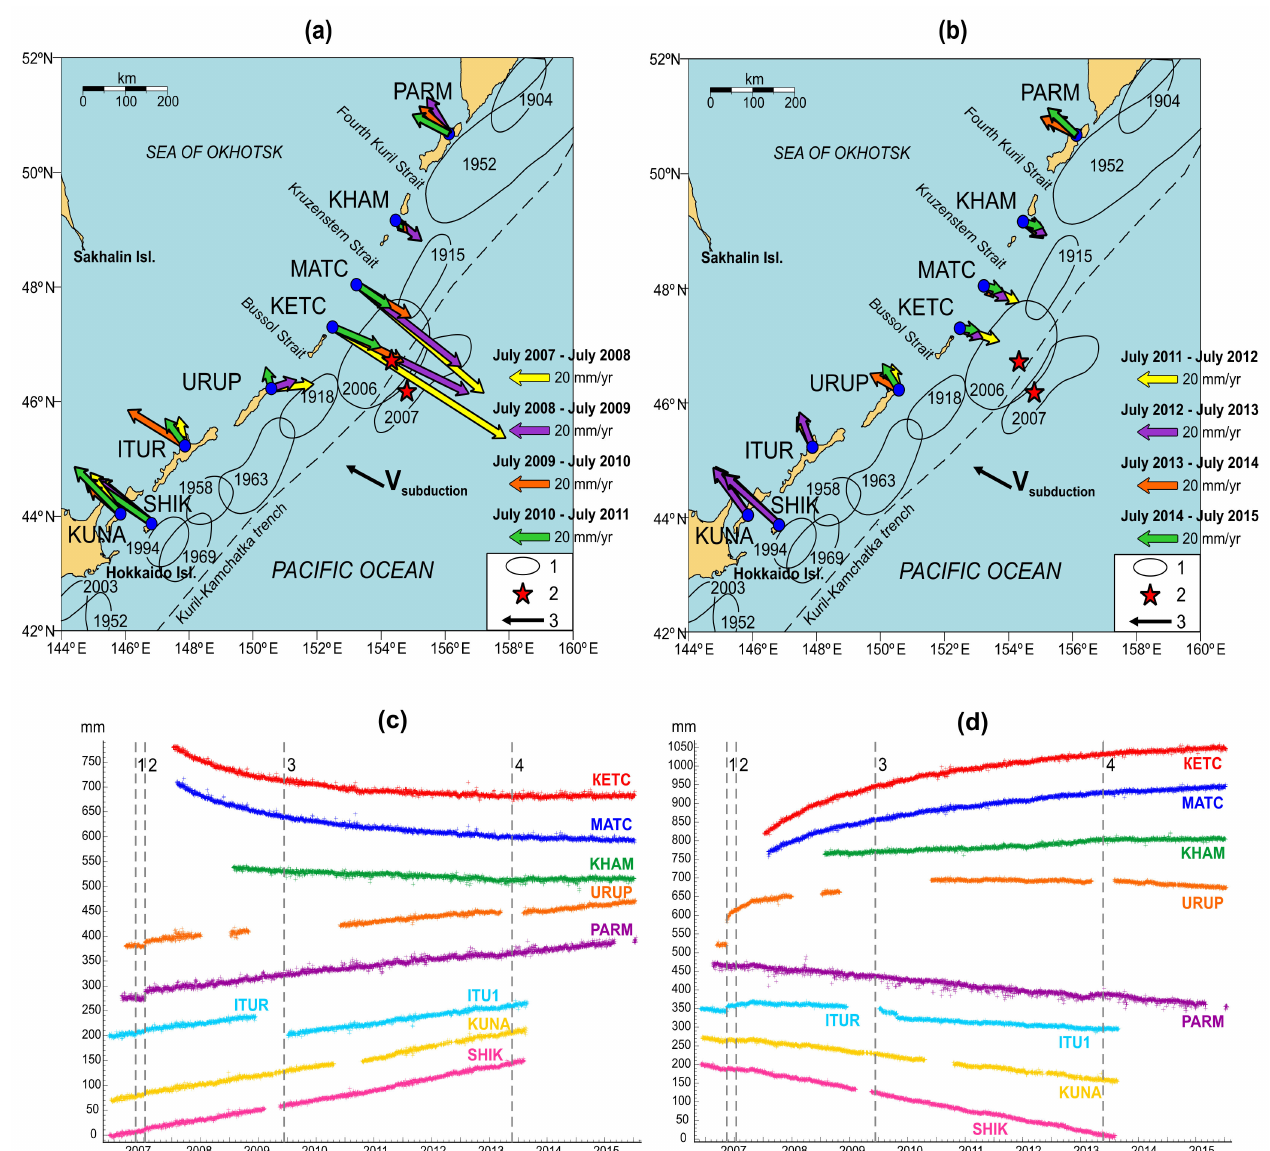
Figure 4. GNSS-observed motions in Kuril subduction zone after large Simushir earthquakes modified from [16]. Upper panel shows velocity vectors measured by the Kuril GNSS stations during time intervals from May 2007 to May 2011 ( a ) and from May 2011 to May 2015 ( b ). (1) Sources of strongest earthquakes with M ≥ 8; (2) main shocks of earthquakes in 2006 and 2007; (3) subduction velocity equal to 80 mm/yr. The velocities indicated here are relative to the North American lithospheric plate. Lower panel shows northern ( c ) and eastern ( d ) components of the displacements of the Kuril network observation points. Dashed vertical lines denote the moments: (1) Simushir earthquake in 2006; (2) Simushir earthquake in 2007; (3) Eruption of Sarychev peak in 2009; (4) deep earthquake of the Sea of Okhotsk in